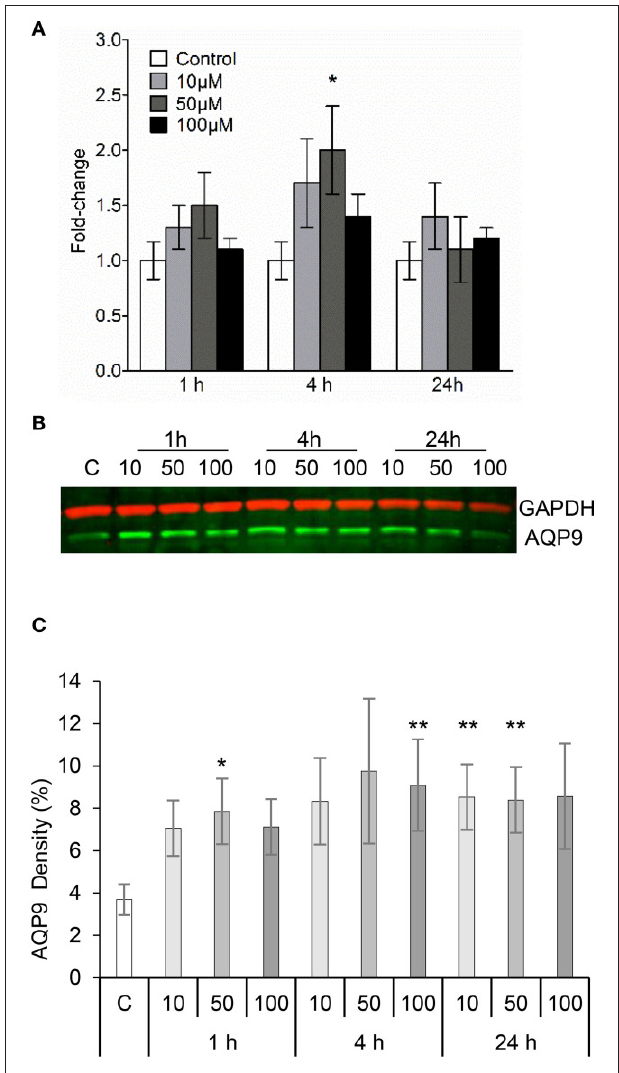
FIGURE 3 | 3O-C 12 -HSL increases the expression of AQP9 in macrophages. (A) Changes in AQP9 mRNA levels of macrophages. Cells were treated either with diluent (Control) or with 10, 50, and 100 µ M 3O-C 12 -HSL for 1, 4, and 24h, and qPCR was performed using GAPDH as a reference gene. Two-way ANOVA suggested that the concentration but not the different times of observation primarily affected the expression rate. Significant difference is indicated with * when P < 0.05, as analyzed by Bonferroni’s post-test ( n = 6). (B) Cells were treated either with diluent as a control (C) or with 10, 50, and 100 µ M 3O-C 12 -HSL for 1, 4, or 24h. Whole cell lysates were analyzed with immunoblotting for AQP9 and GAPDH for loading control. The blot is representative of six independent experiments from six different donors. (C) Quantification of blots. AQP9 levels normalized to the GAPDH control are indicated as percent (%). Values are the mean ± SE ( n = 6). Significant differences are indicated with * when P < 0.05 and ** when P < 0.01, as analyzed by one-way ANOVA-Friedman and Dunn’s multiple comparison